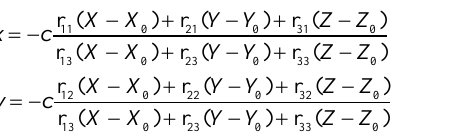
image plane. Practically, to generate the reflectance and RGB